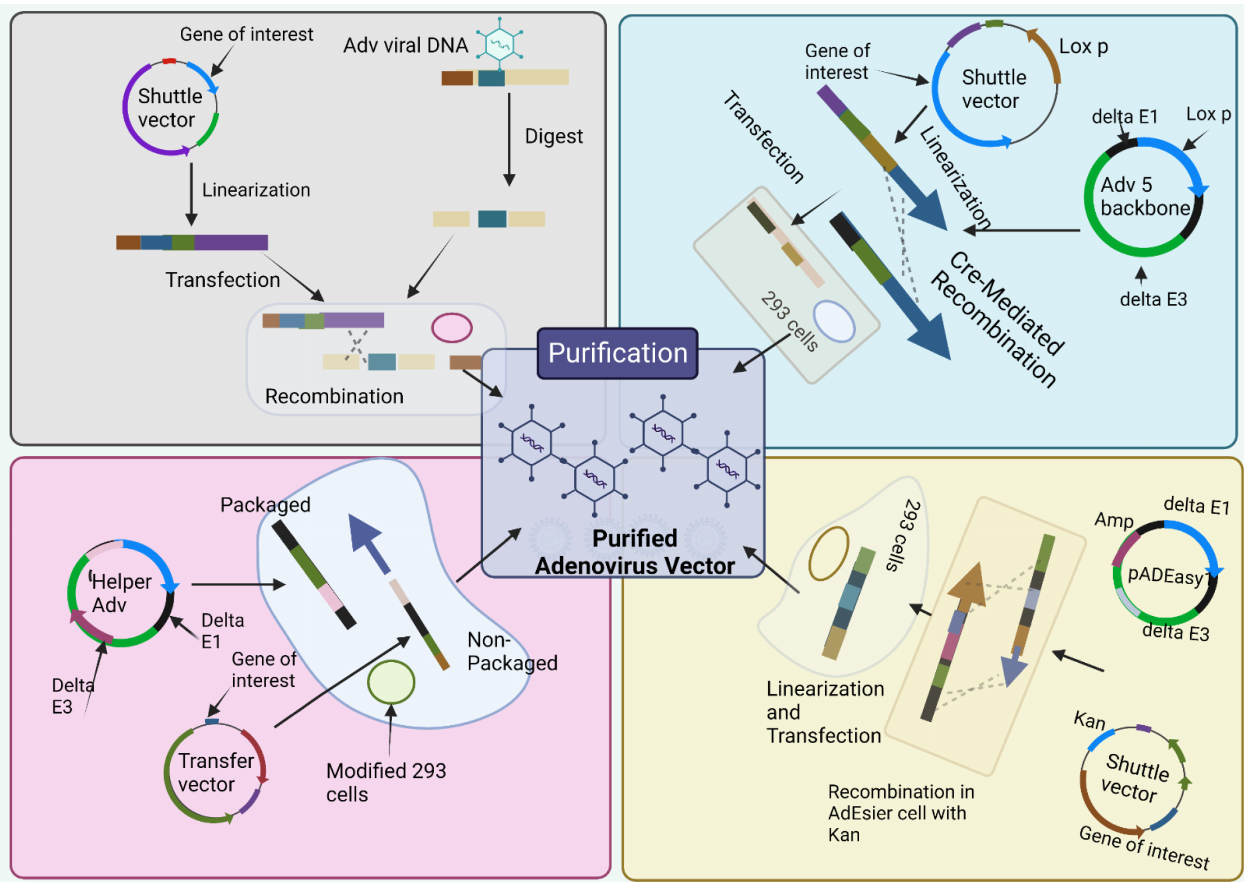
Figure 3. Production methods for adenoviral vectors. ( 1 ) the traditional method —recombination in HEK-293 cells. The gene of interest (GOI) is first cloned into a shuttle vector, which contains 5 (cid:48) -ITR, packaging signal, and homologous regions to the adenoviral genome. Adenoviruses are